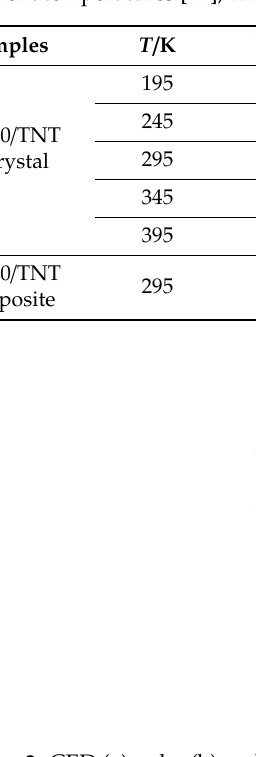
Figure 1. Intermolecular hydrogen bond of CL-20/TNT cocrystal [8], with permission from Han Neng Cai Liao, 2012.